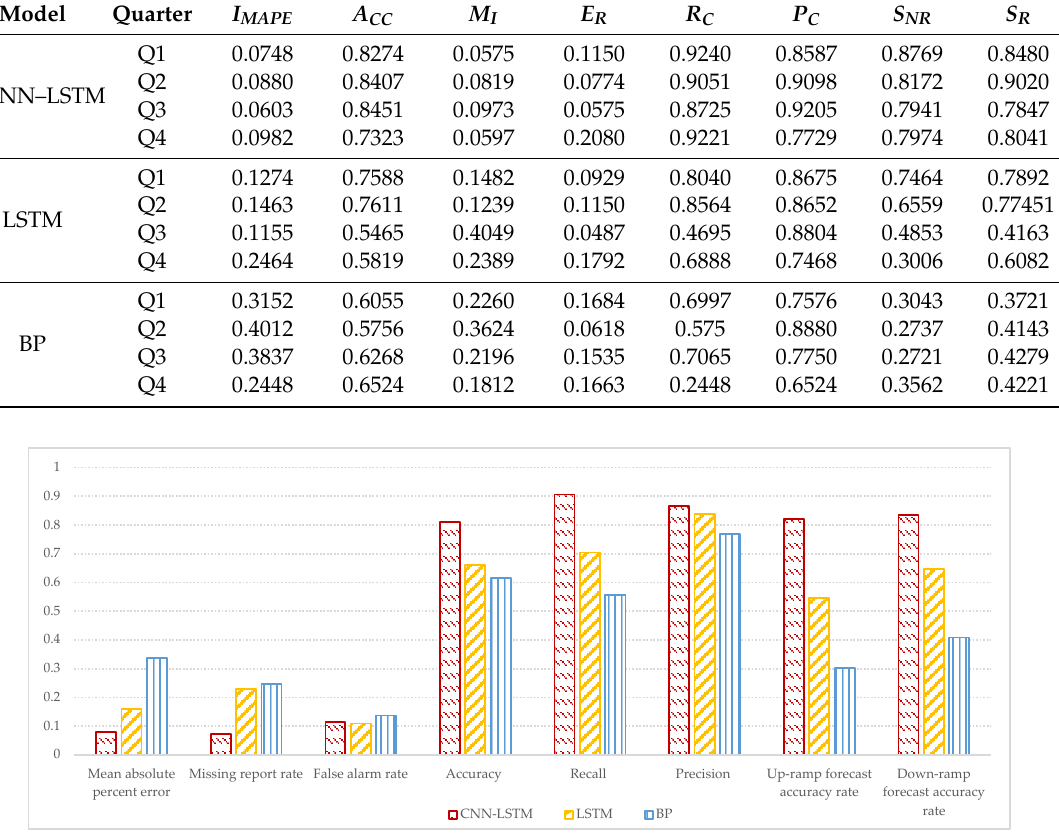
Figure 11. Comparison of annual average evaluation indexes with different forecast models.